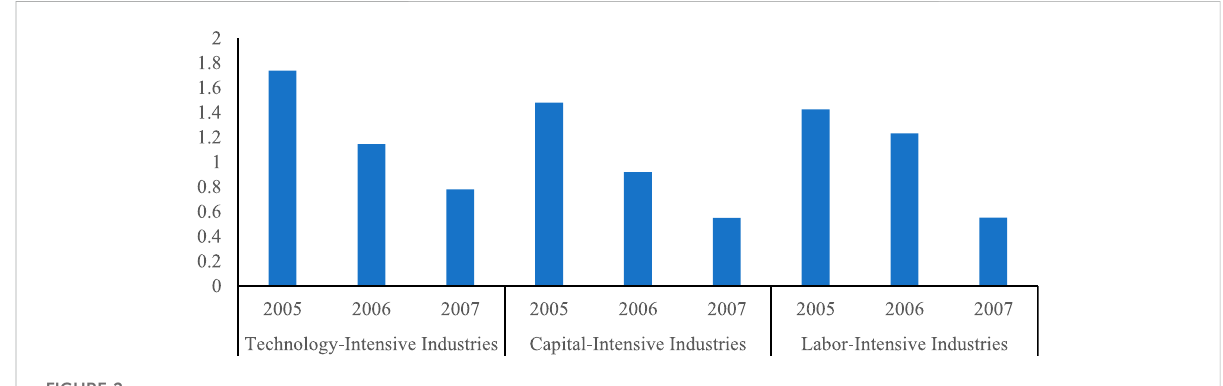
FIGURE 2 Changes in GTFP of Taiwan-funded enterprises of different industrial types from 2005 to 2007. Note: The criteria for the classi fi cation of the types of Taiwan-funded enterprises refer to Yang et al.